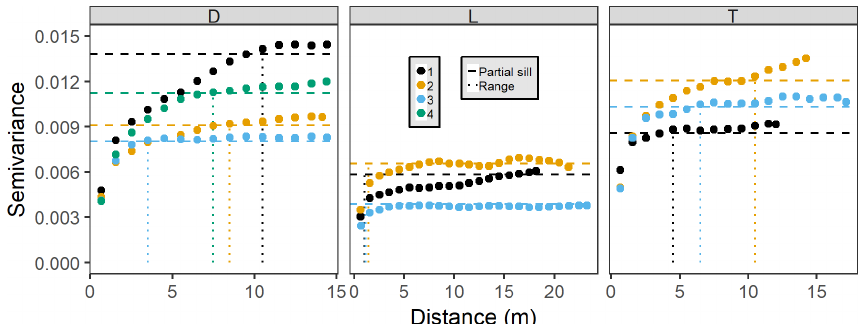
Figure 4. Omnidirectional semivariograms for site elevations by hydrogeomorphic category (D refers to depression, L refers to lowland, and T refers to transition). Sites are colored according to their number within their hydrogeomorphic category. Dotted vertical lines indicate best-fit ranges, and horizontal dashed lines indicate best-fit partial sills (sill – nugget).